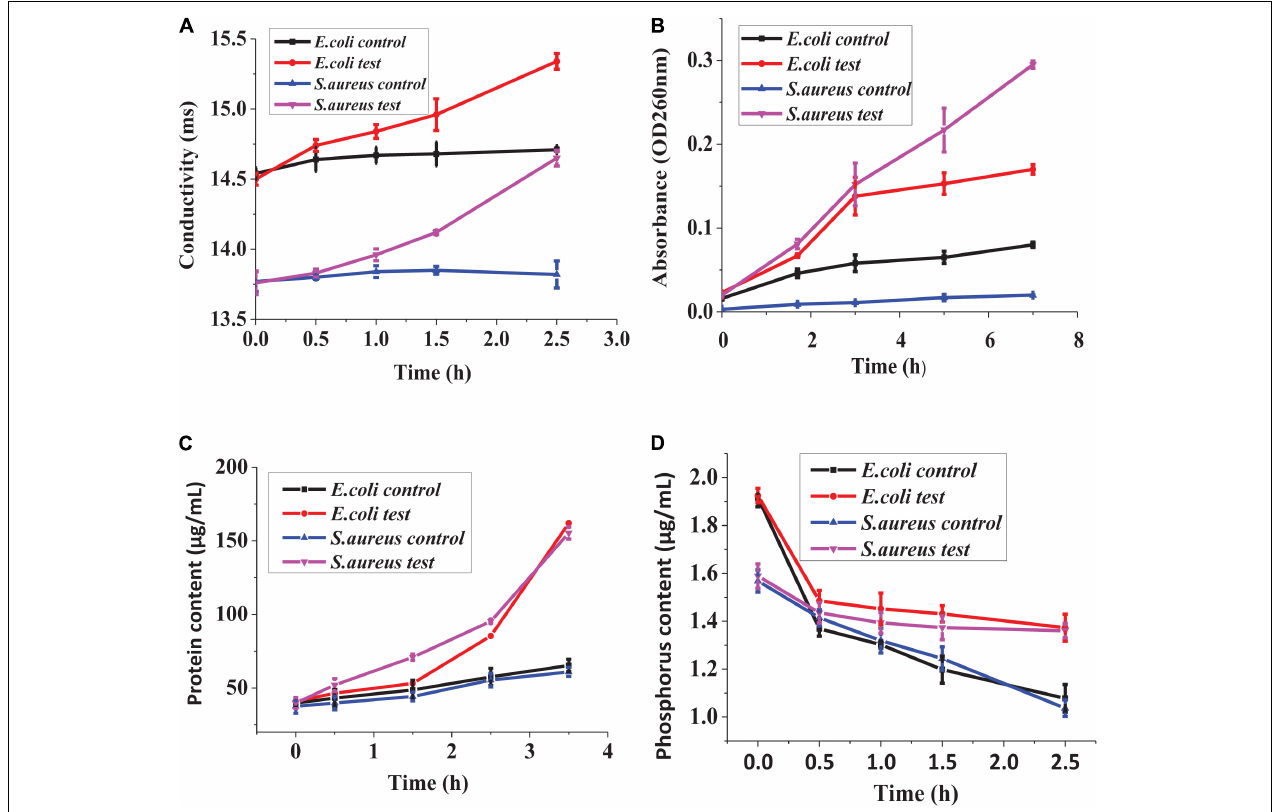
FIGURE 6 | Effect of lacidophilin on cell membrane permeability, leakage of electrolyte (A) , leakage of nucleic acid (B) , leakage of proteins (C) , phosphorus metabolism (D)